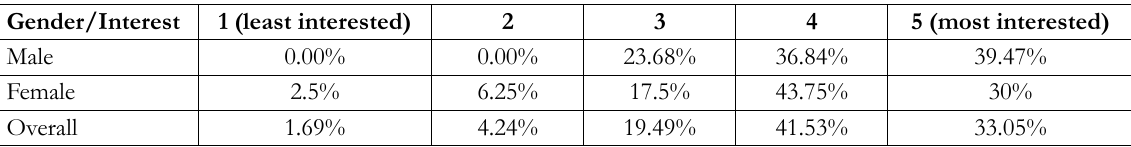
Table 4. Interests in Engineering After the Program